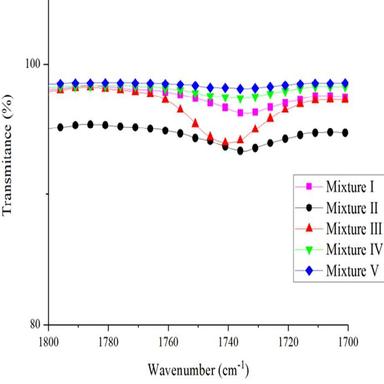
Comparison between mixtures in the range of the spectra associated with degradation.